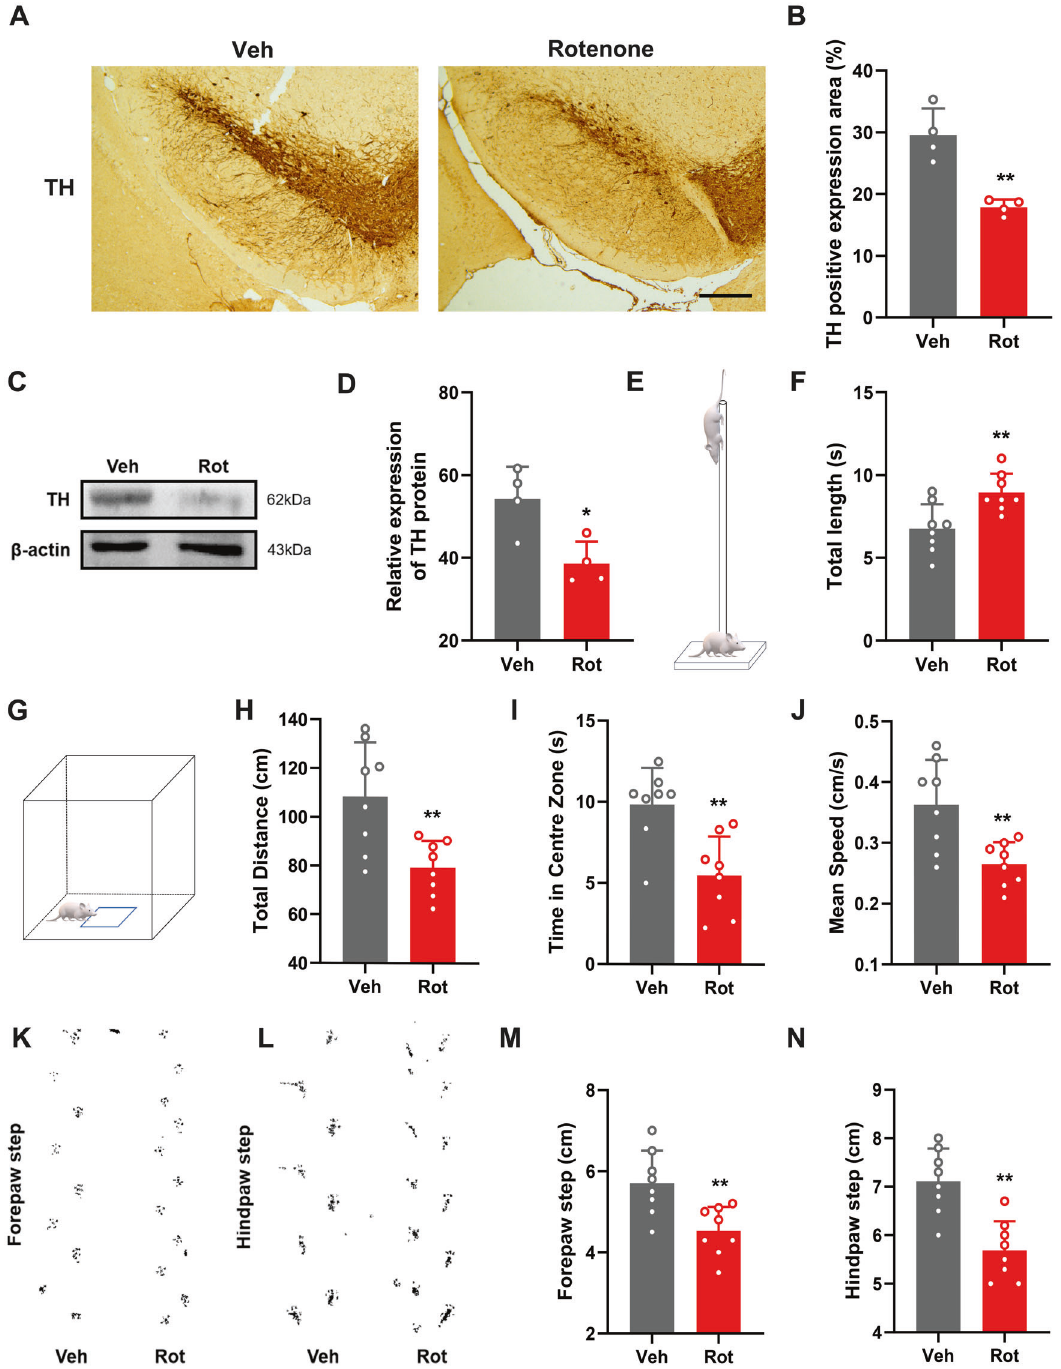
Fig. 1 Mice treated with rotenone showed PD-like pathological changes and motor dysfunction. A , B Number of TH-positive cells in the brain tissue of PD model mice treated with rotenone; scale bars, 500 μ m ( n = 4). C , D Western blot analysis of the TH protein levels in the SN of PD model mice treated with rotenone ( n = 4). E – N Pole-climbing test E , F , fi eld test ( G – J ) and step measurement K – N were performed on PD model mice treated with rotenone to evaluate the exercise ability ( n = 8). Data are presented as mean ± SD. * P < 0.05, ** P <